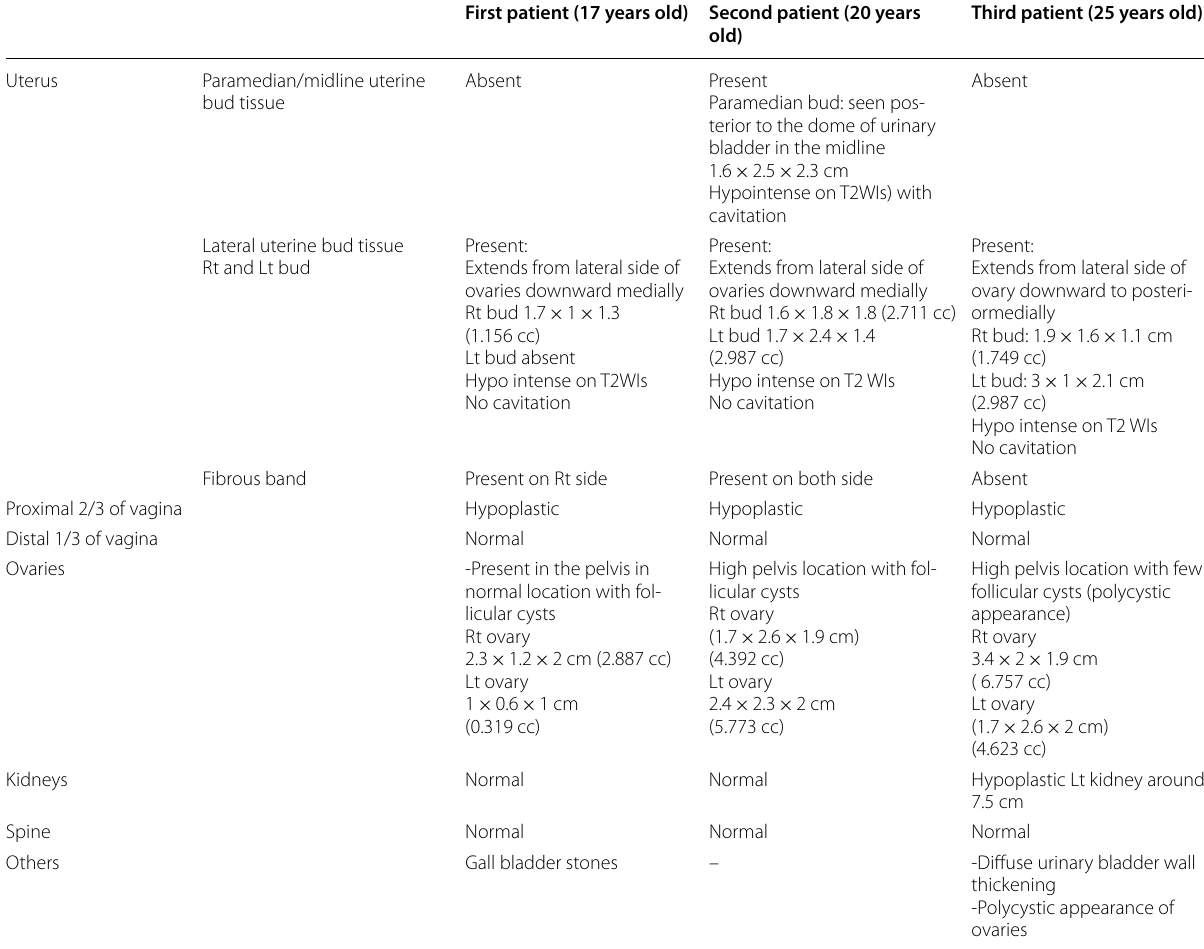
First patient (17 years old) Second patient (20 years Third patient (25 years old) old)